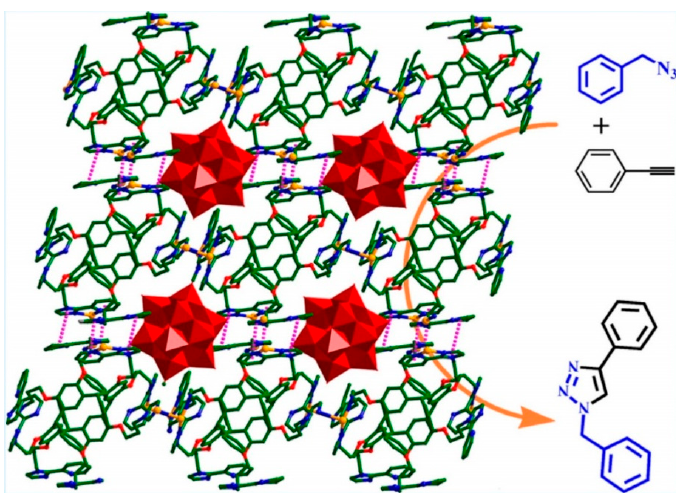
Figure 17. Three-dimensional copper-based MOF for the synthesis of 1,2,3 triazole. Reproduced from [112] with permission from the American Chemical Society, copyright year: 2018. Table 6. Copper-based MOFs for the synthesis of 1,2,3-triazole via the CuAAC reaction.